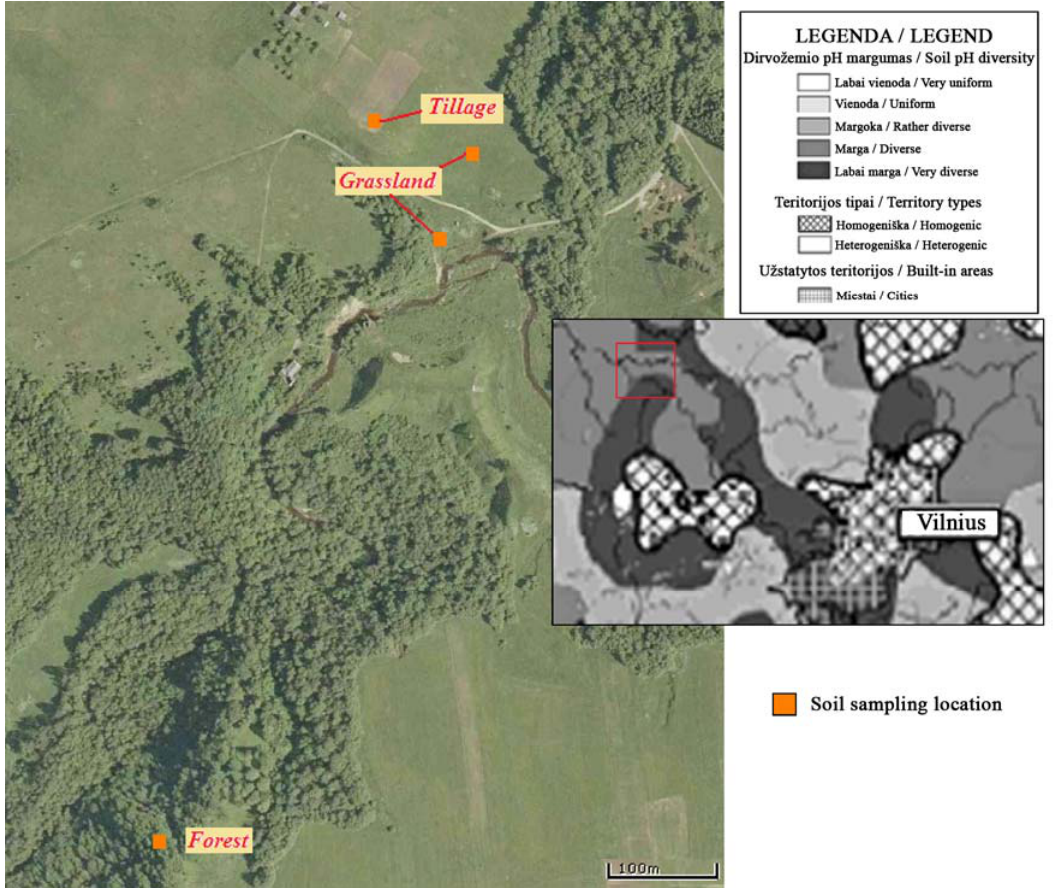
Fig. 1. The diversity of the spatial structure of soil pH and sampling place next to Buividai residential